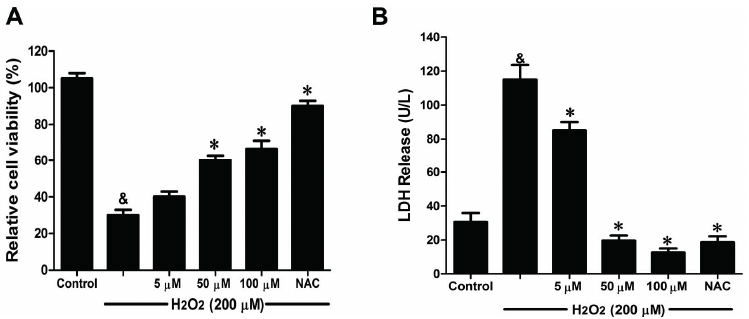
Figure 5. The danshensu-cysteine conjugate N -(( R )-3-benzylthio-1-methoxy-1-oxo-2-propanyl)- 2-acetoxy-3-(3,4-diacetoxyphenyl) propanamide (DSC) attenuated H 2 O 2 -induced cell damage in human umbilical vein endothelial cells (HUVEC). HUVEC were incubated with indicated concentrations of DSC or NAC for 4 h, then stimulated with H 2 O 2 (200 μ M) for 12 h; the cell viability ( A ) and LDH ( B ) release were measured, respectively. Data shown are means ± SEM, & p < 0.05 compared with unstimulated cells, * p < 0.05 compared with H 2 O 2 -stimulated cells. Data were from at least three independent experiments, each performed in